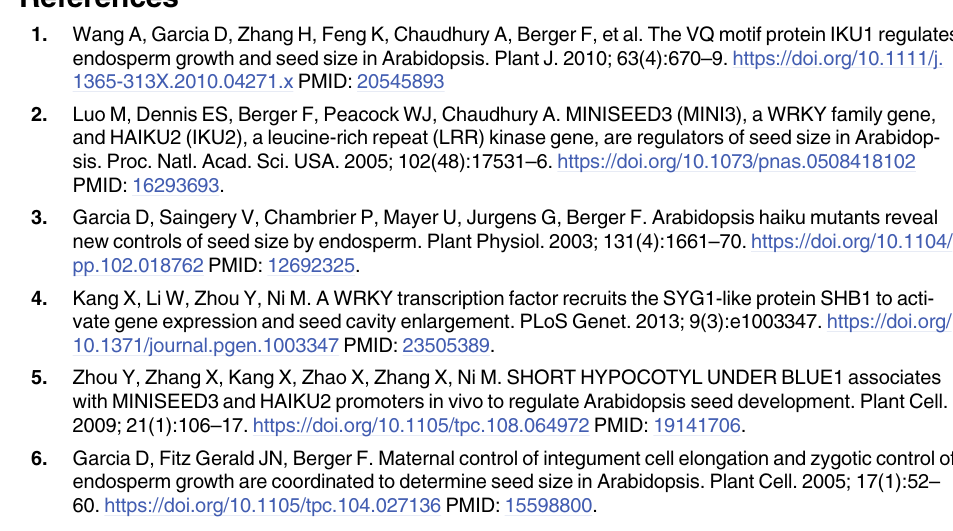
S1 Table. Summary of the parent-of-origin genotypes and the corresponding parental TTG2 dosages. S2 Table. Primers used in this